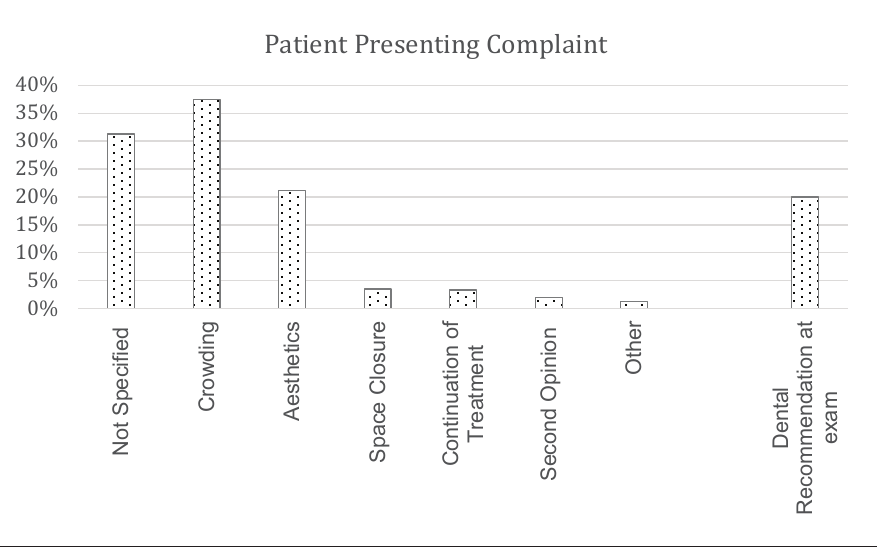
Figure 2. Figure 2. Tally of patient complaint(s), which also considers more than one complaint from a particular patient if indicated in their clinical records. Dental recommendation at exam relates to referrals to orthodontists when a malocclusion was identified by the examining